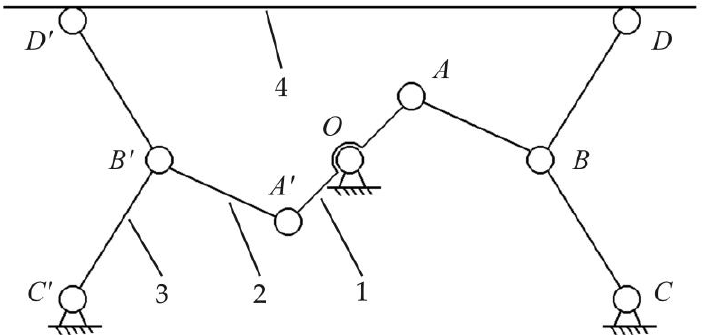
Figure 1. Schematic diagram of drive mechanism of die-cutting device. 1-crankshaft; 2-power rod; 3-drive rod; 4-moving platform.